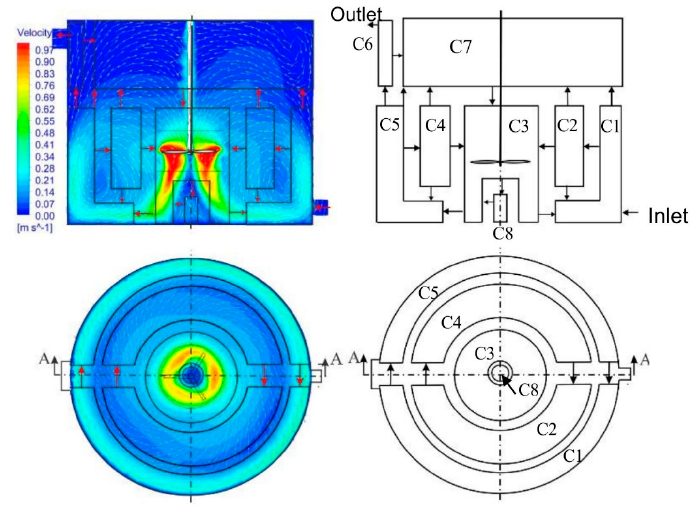
Figure 5. Derivation of the CM from the CFD model: front and top/bottom plane view (left) and CM (right).